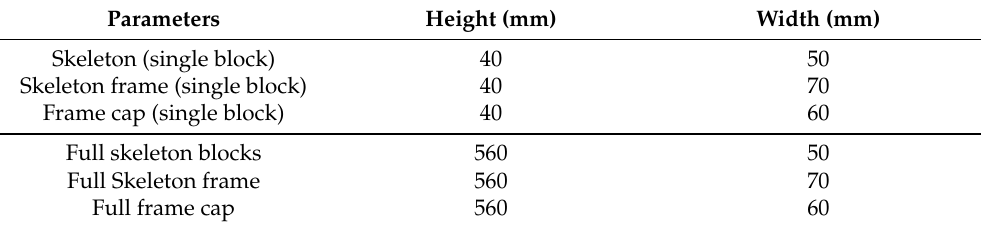
Table 2. Dimensions of the designed posture-correcting actuator.